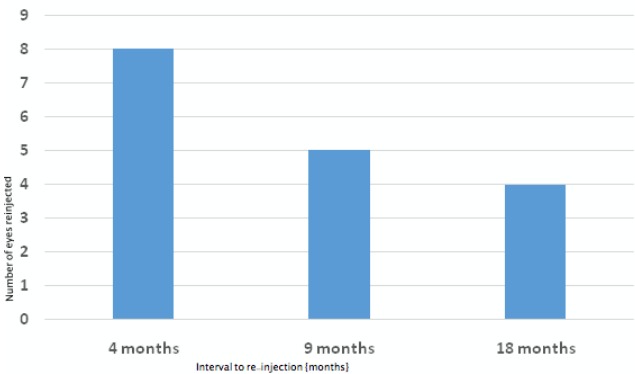
Figure 7: Mean interval to